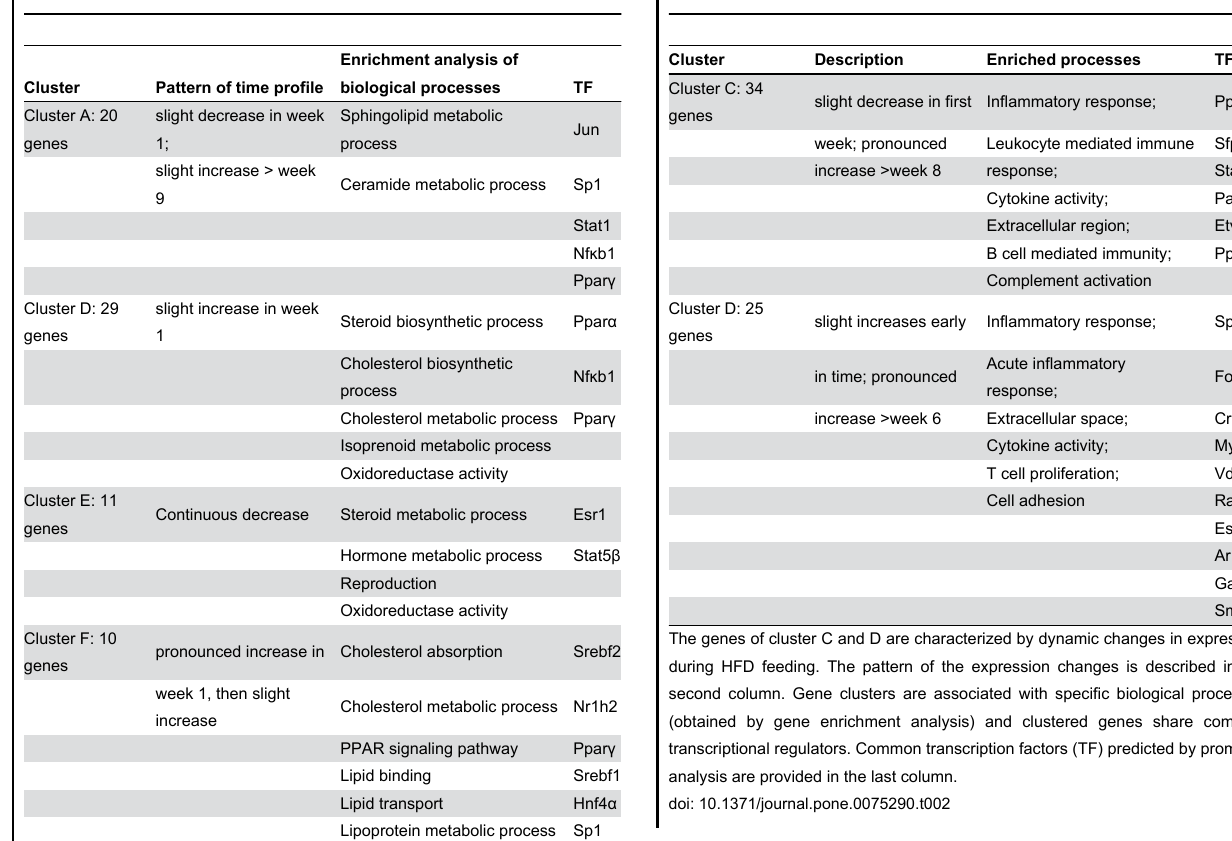
Table 1. Genes of lipid metabolism with dynamic changes over time.